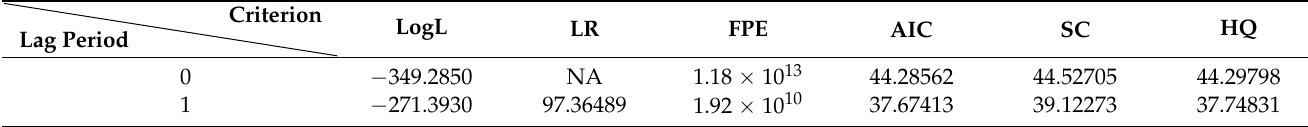
Table 8. Cointegration coefficient and standardization.